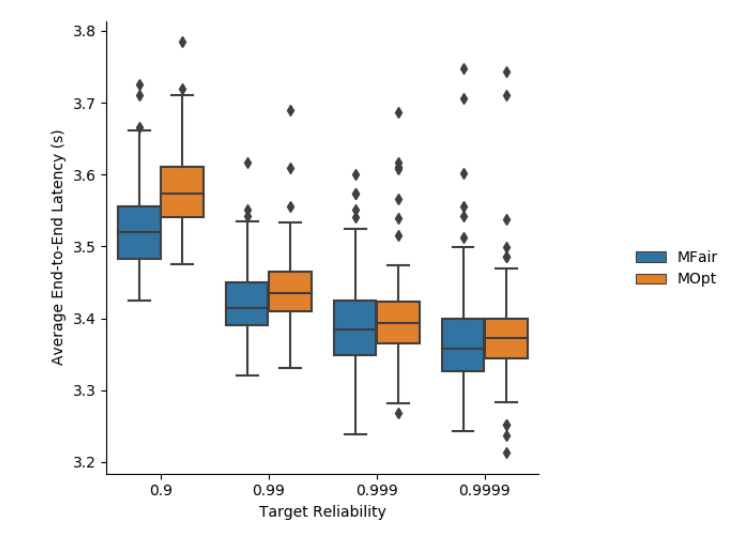
Figure 8. Average end-to-end latency obtained with MFair and MOpt .